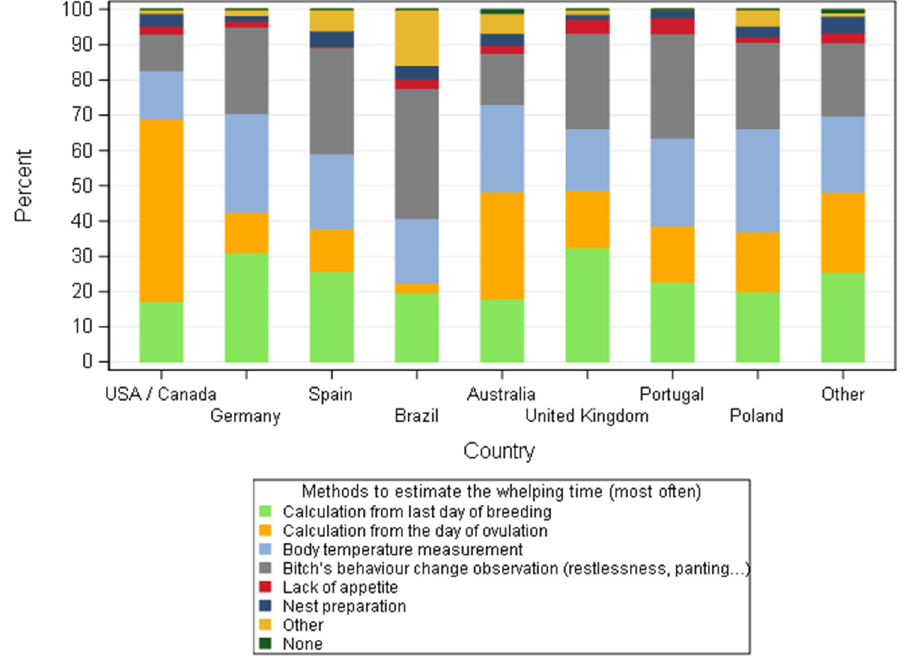
Figure 11. Methods, most often used, to estimate the whelping time according to dog breeders by country—all responders ( n = 668).